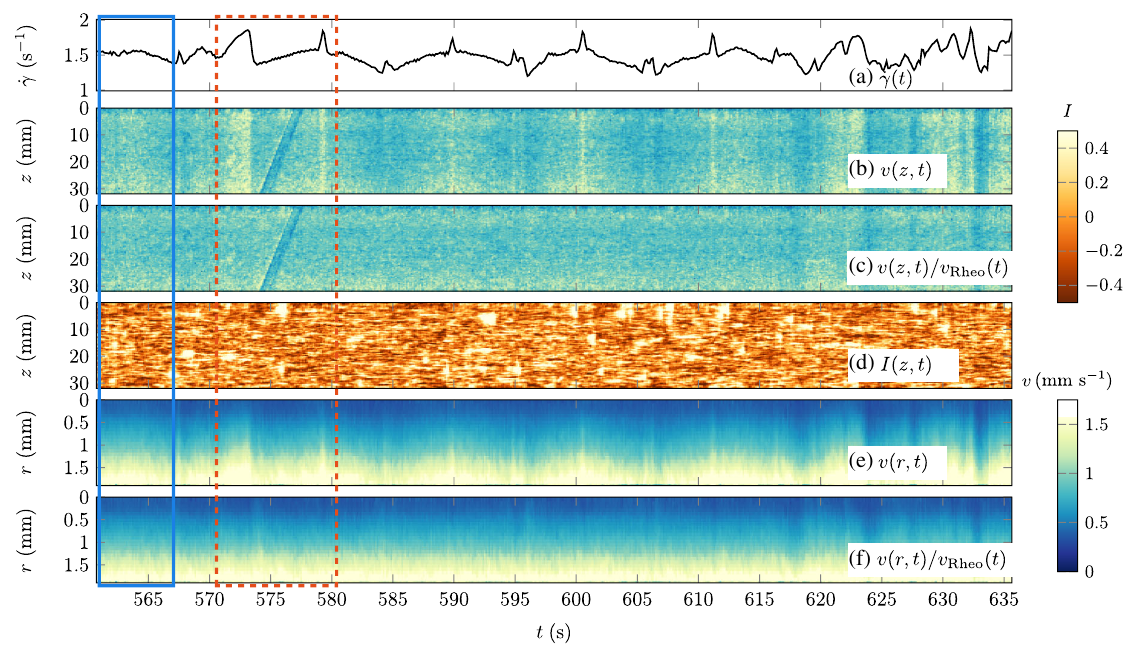
FIG. 13. Comparison between global and local dynamics in regime I for σ ¼ 12 Pa. (a) Global shear rate response _ γ ð t Þ recorded by the rheometer as a function of time. (b) – (f) Spatiotemporal diagrams of the velocity v ð r; z; t Þ and of the ultrasonic intensity I ð r; z; t Þ as defined in Appendix 5. The boxes highlight a diffusive, quiescent phase (blue) and the ballistic phase associated with a propagating event (red) discussed in the main text and enlarged in Fig. 4(b). See also Video 1.